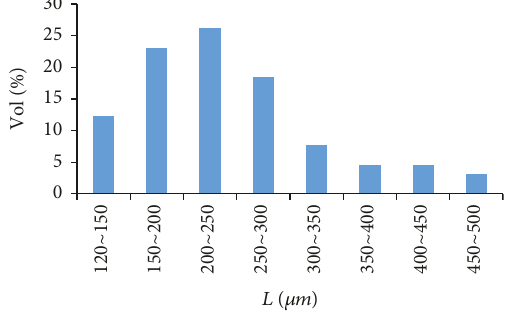
Figure 8: Fiber length